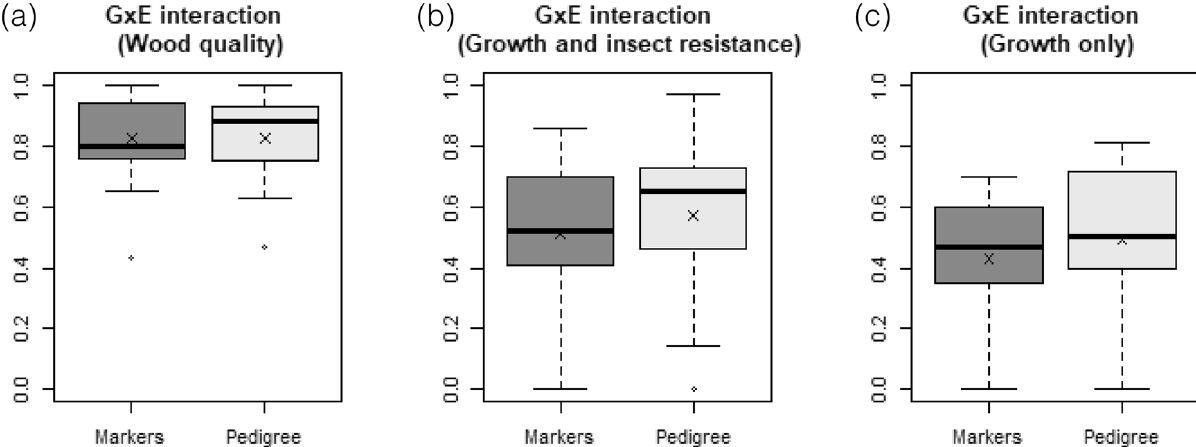
Figure 2. Genotype-by-environment ( G x E ) interaction for ( a ) wood quality, ( b ) growth and insect resistance, and ( c ) only growth traits in conifers. G x E interaction was not presented separately for insect resistance